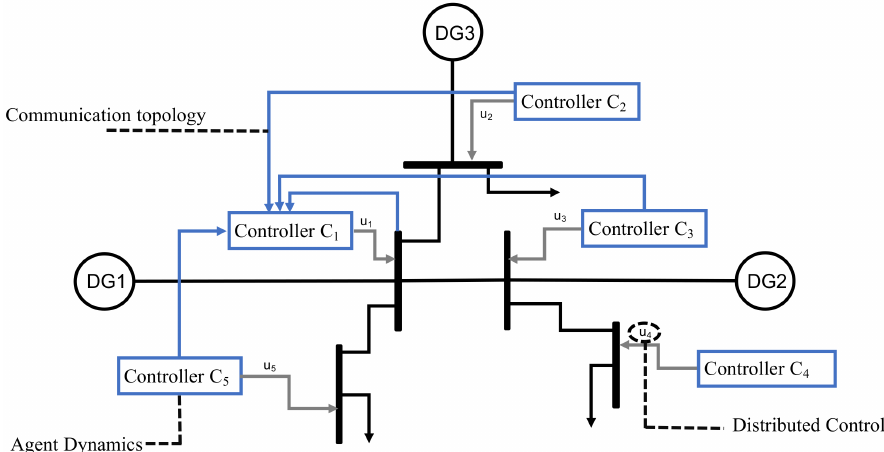
Figure 1. Cooperative smart controller network as a multi-agent dynamic